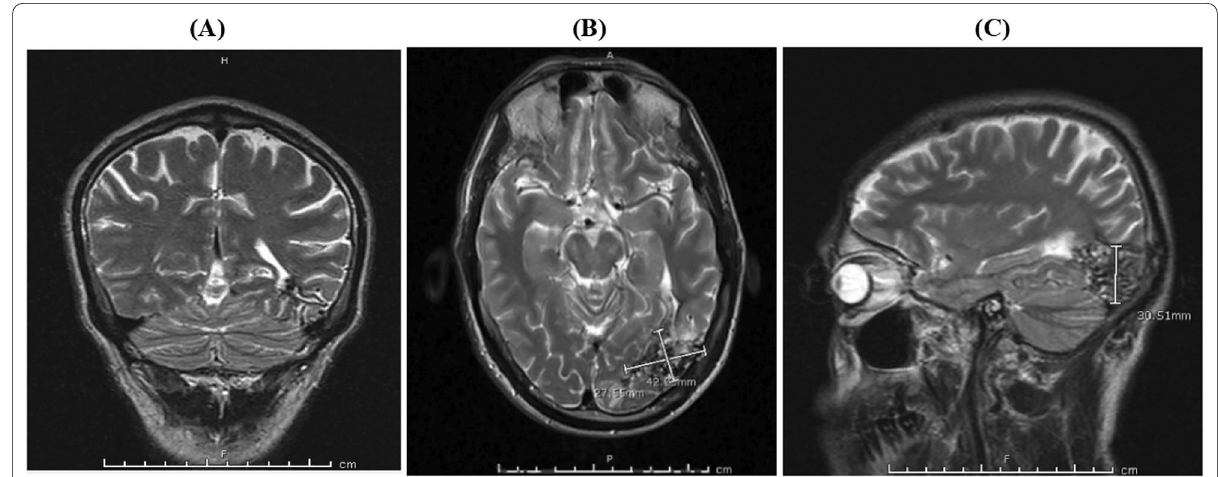
Fig. 1 MRI of AVM case. A Coronal view. B Axial view. C Sagittal view. Evidence of serpentine flow void nidus seen in the left occipital lobe measuring ~ 27 42 30 mm. No surrounding edema or mass × ×